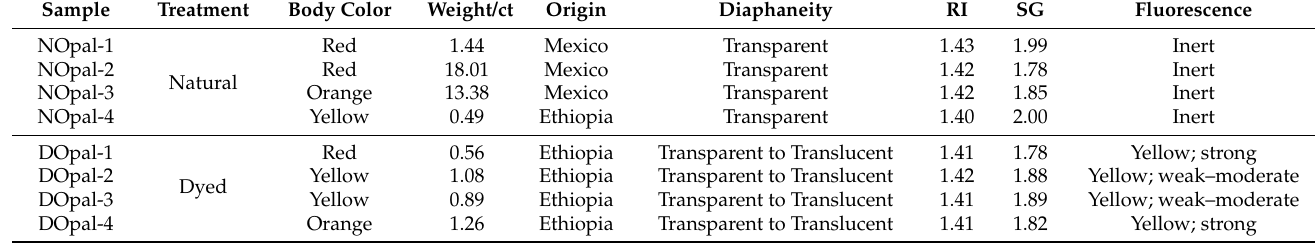
Table 1. Descriptions of gemological properties.